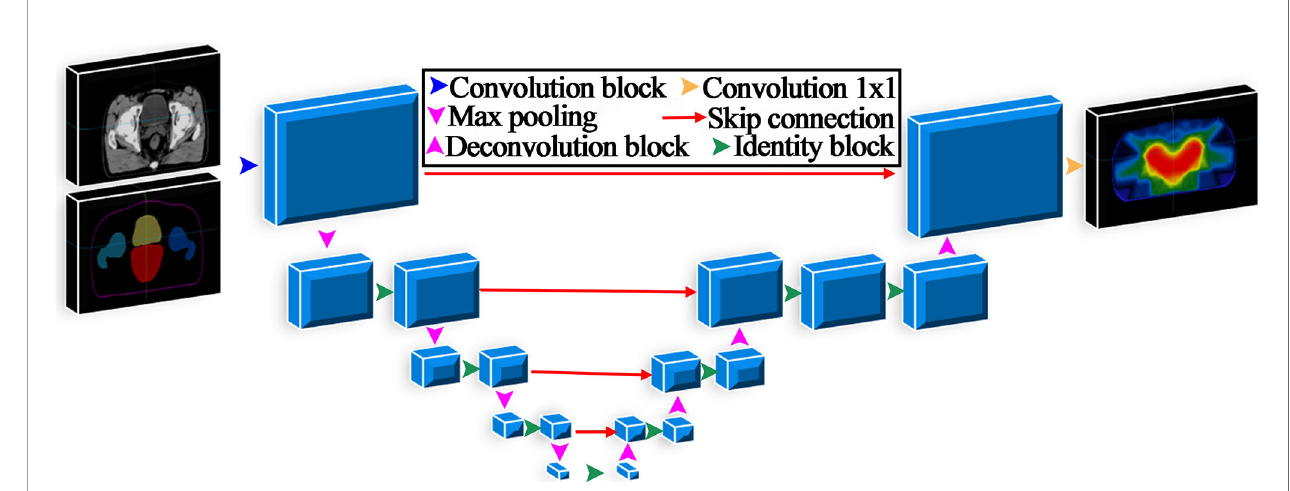
FIGURE 1 | Architecture of the 3D U-Net used for dose